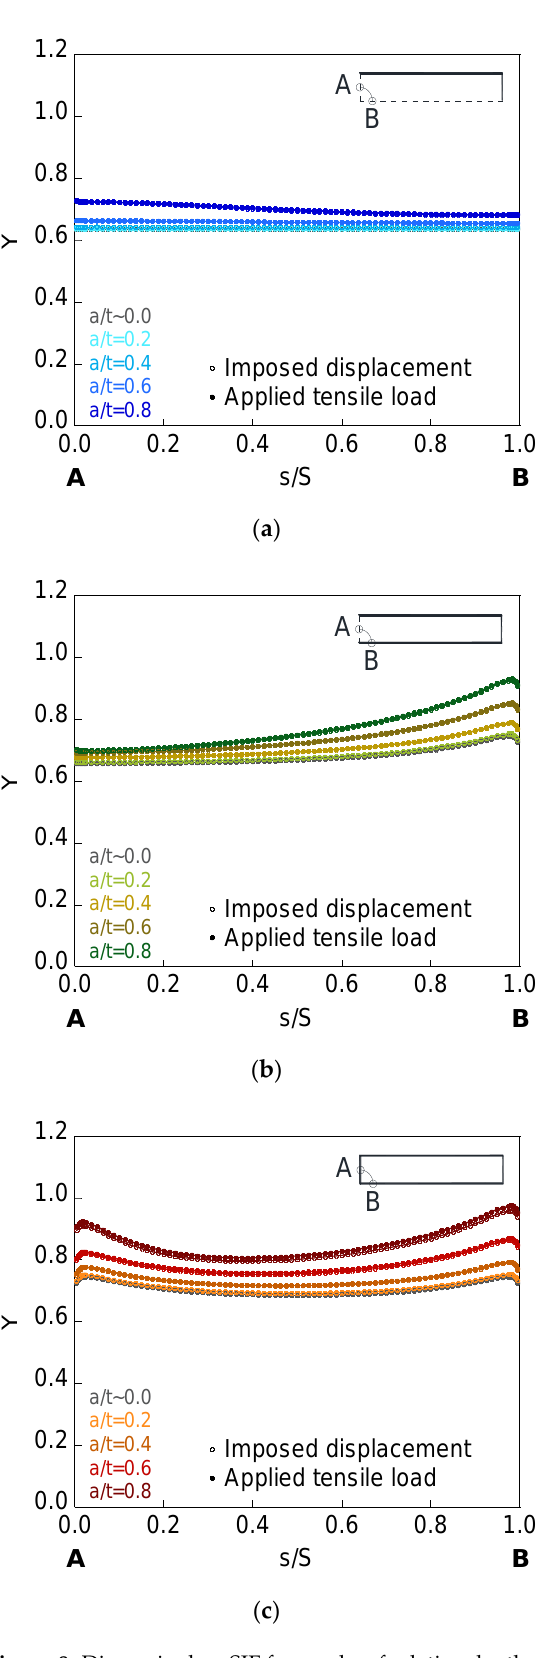
Figure 8. Dimensionless SIF for cracks of relative depths a / t = {~0.0, 0.2, 0.4, 0.6, 0.8} and aspect ratio a / b = 1.0 in a finite-thickness plate for the ( a ) embedded configuration, ( b ) superficial configuration, and ( c ) corner configuration.